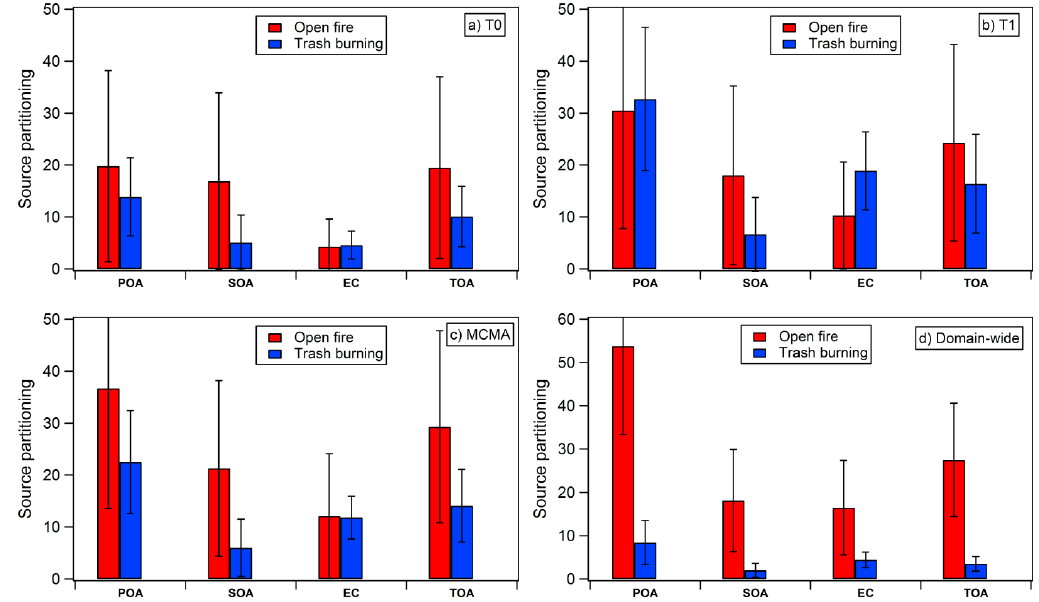
Fig. 11 1253 Fig. 11. Partitioning of the contributions of different emission sources to OA and EC concentrations (a) at T0, (b) at T1, (c) in MCMA, and (d) domain-wide. The error bars in the graph represent the standard